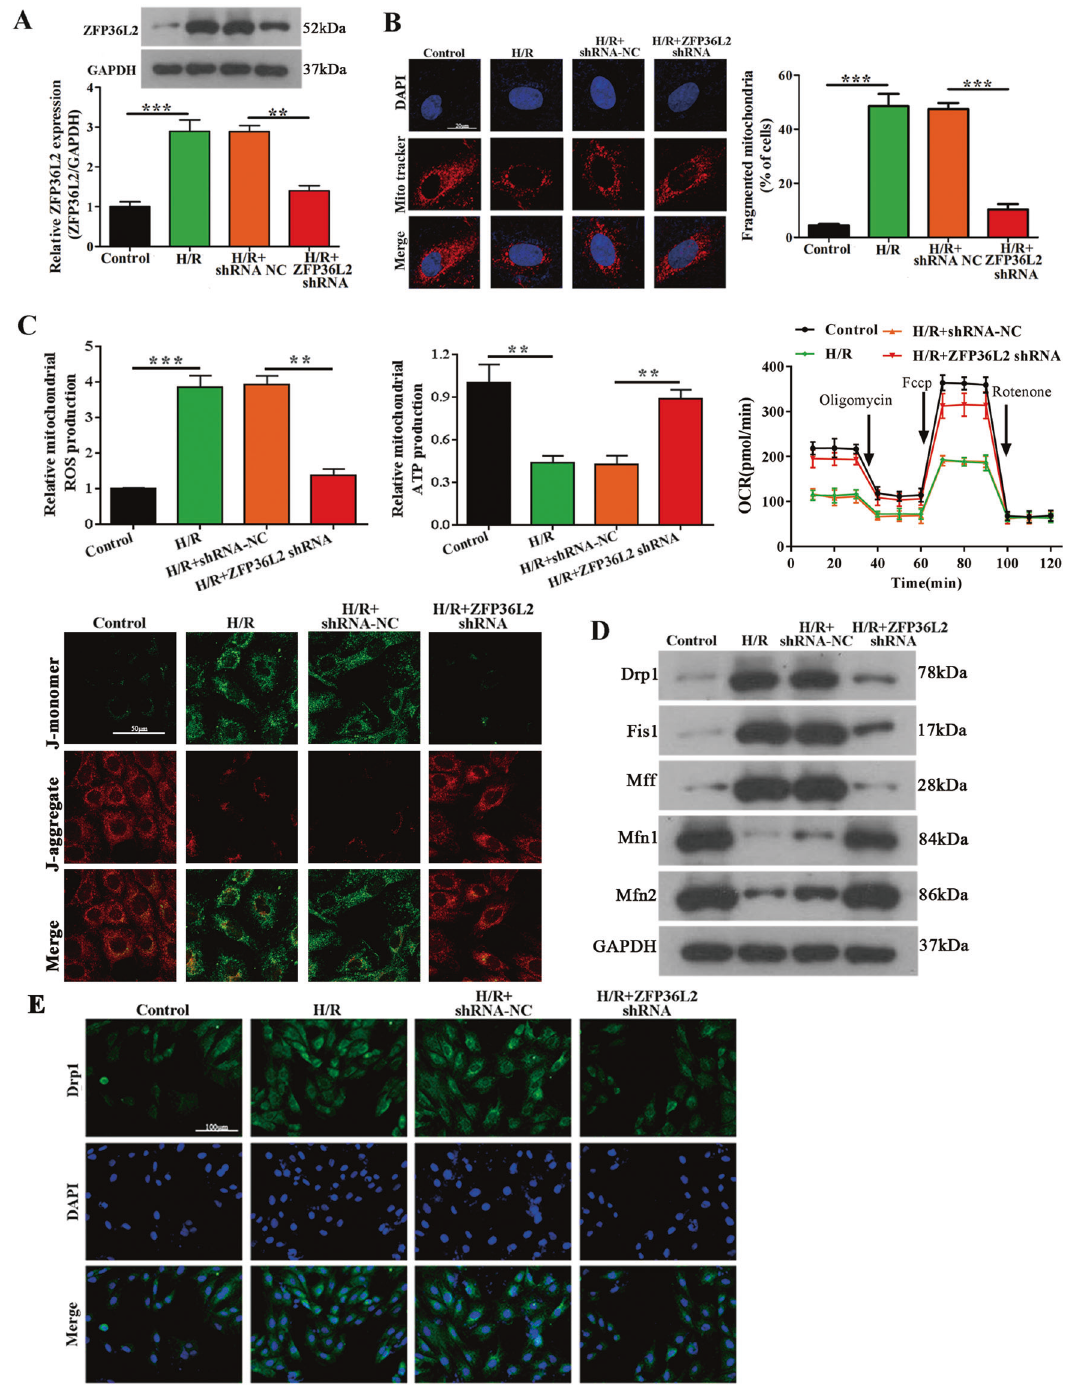
Fig. 2 ZFP36L2 knockdown suppresses hypoxia/reoxygenation (H/R) injury and alleviates mitochondrial fusion and fi ssion in vitro. A A H/R injury model was established by inducing hypoxia for 4 h followed by reoxygenation for 1 h. The mRNA and protein expression of ZFP36L2 in cardiomyocytes were determined by qRT-PCR and western blot, respectively ( n = 3). B Representative micrographs of cardiomyocytes after H/R injury expressing normal control shRNA or shRNA against ZFP36L2 stained with MitoTracker Red (mitochondria) and 4 ′ , 6-diamidino-2-phenylindole (DAPI) (nucleus). Quanti fi cation of cells with fragmented mitochondria was detected under different conditions. At least 100 cells were counted per condition (Scale bar = 20 μ m) ( n = 3). C The levels of ROS, ATP and OCR were measured to evaluate mitochondrial function in H/R-treated cardiomyocytes, which was transfected with ZFP36L2 shRNA or shRNA NC. JC-1staining (2 µg/ ml) was used to analyze mitochondrial membrane potential ( △ Ψ m) (Scale bar = 50 μ m) ( n = 3). D Expression of mitochondrial fusion-related genes Drp1, Fis1, Mff, Mfn1, and Mfn2 after cardiomyocytes H/R treatment was evaluated by western blot ( n = 3). E Representative micrographs from immuno fl uorescence assays of cardiomyocytes stained for Drp1 (green) and the nucleus (DAPI) (Scale bar = 100 μ m) ( n = 3). ** P < 0.01; *** P <